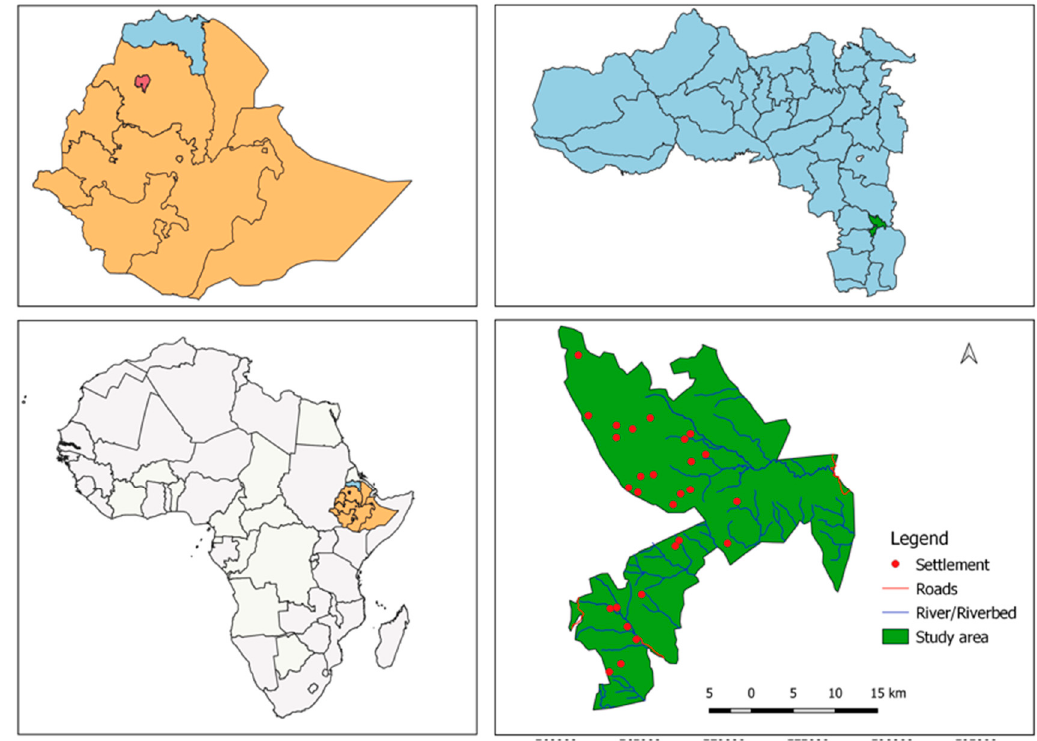
Figure 2. Map of Wujig Mahgo Waren forest in Tigray region, Northern Ethiopia.